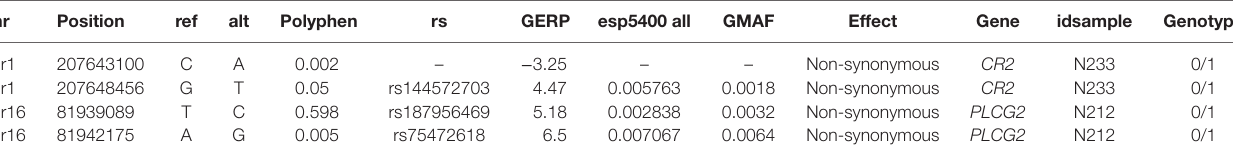
TaBle 4 | Compound heterozygotes at common variable immunodeficiency (CVID) genes. chr Position